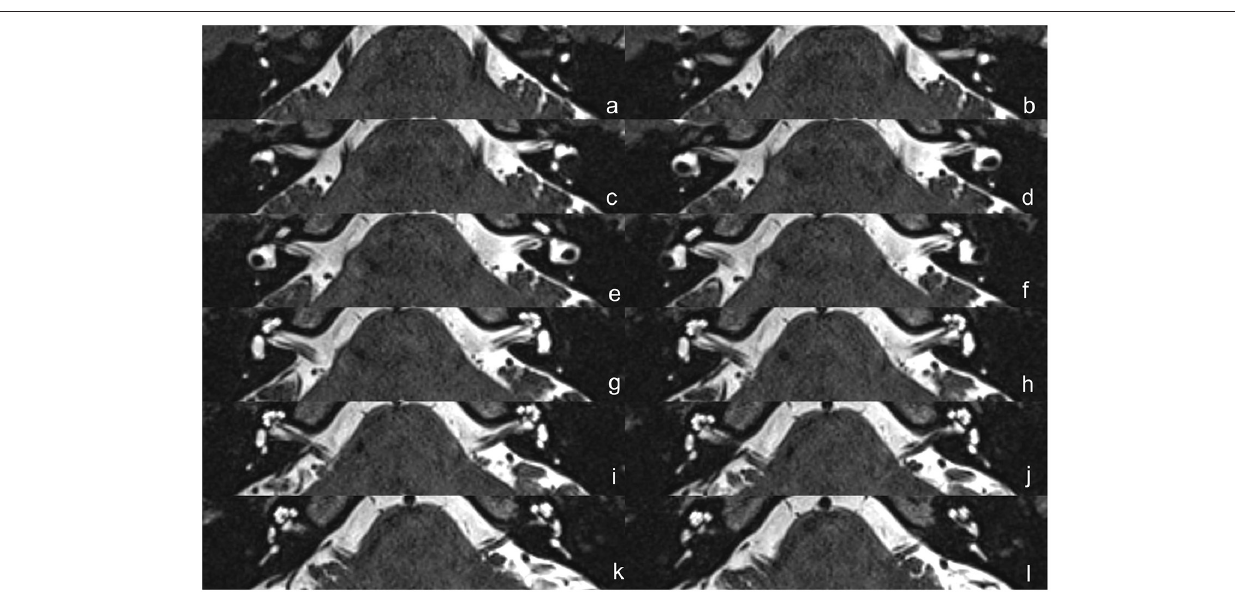
FIGURE 3 | The 3D-SPACE MRI images of a 48-year-old female with VM. (a–l) Axial, high-resolution, and T2-weighted MRI scan showing non-visualization of the vestibular aqueduct on both sides. 3D-SPACE, three-dimensional sampling perfection with application optimized contrasts using different flip angle evolutions, VM, vestibular